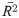
Windowed time-matching.The above plots illustrate time-matching when grooming durations are summed over time windows of 20 minutes, 40 minutes, 1 hour and 4 hours. The R2¯ values in parentheses in the caption beneath each figure shows the average of the R2 values over each regression within the comparison group. When we separate the data according to the delay Δ we see that most time-matching is accounted for by within-bout activity (A). When we restrict attention to delayed time-matching, the effect largely disappears (B).